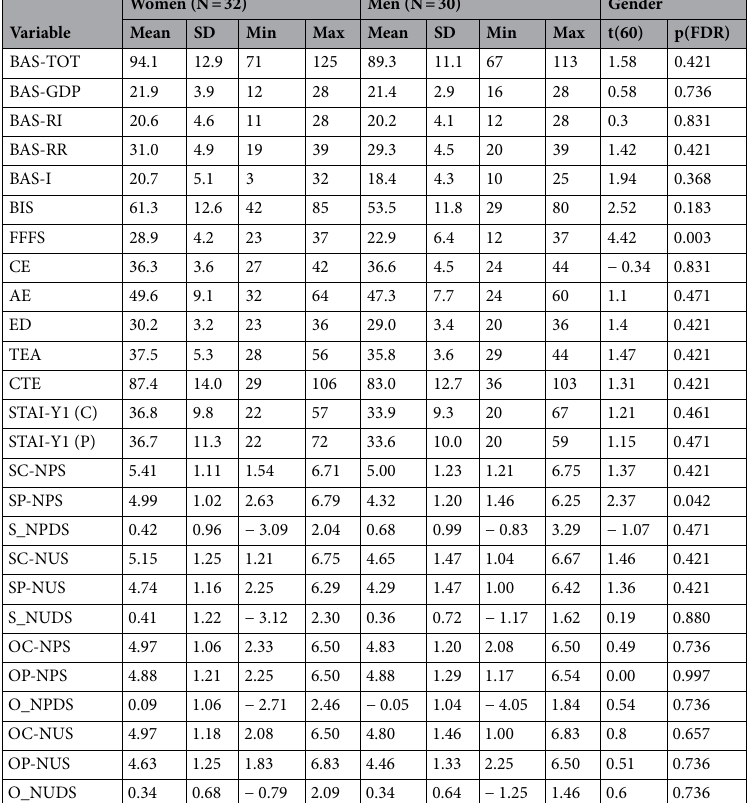
Table 3. Descriptive statistics in women and men participants (1) for the RST-PQ, ECQ, STAI-Y1; (2) for numerical pain and unpleasantness scores: (i) of the Self in the Control (SC-NPS, and SC-NUS), Placebo (SP-NPS, and SP-NUS) treatments and Control minus Placebo difference scores (S_NPDS and S_NUDS); (j) of the Other in the Control (OC-NPS, and OC-NUS), Placebo (OP-NPS, and OP-NUS) treatments and Control minus Placebo difference scores (O_NPDS and O_NUDS). Last two columns: T-test values (Women vs Men) and FDR-corrected p values. M Mean, SD Standard Deviation, Min Minimum, Max Maximum, RST-PQ Reinforcement Sensistivity Theory-Personality Questionnaire, BAS-TOT Behavioral Approach System, BAS-GDP Goal-Drive Persistence, BAS-RI Reward Interest, BAS-RR Reward Reactivity, BAS-I Impulsivity, BIS Behavioural Inhibition System, FFFS Fight-Flight-Freeze System, C State Anxiety in the pain control STAI-Y1, P placebo STAI-Y1 treatments, ECQ Empathy Components Questionnaire, CE Cognitive